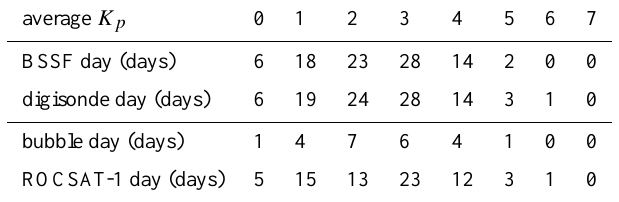
Table 3. Numbers of BSSF day, digisonde day, bubble day, and ROCSAT-1 day for each average K p in the summer months.